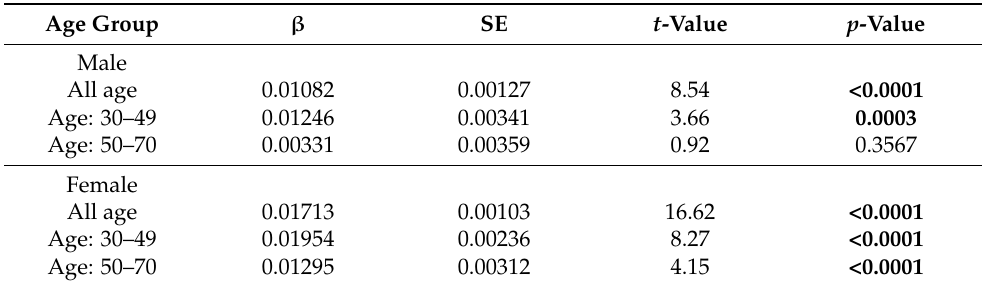
Table 2. Single linear regression between HbA1c levels and age.